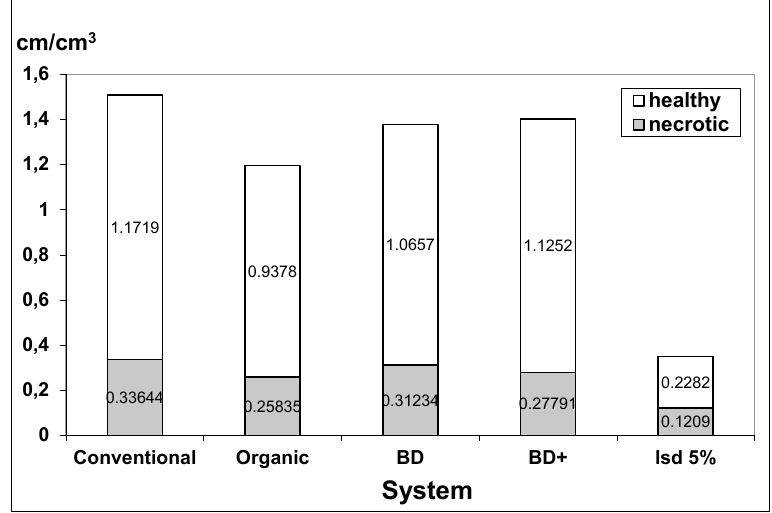
The root to stover + grain relationship was 16.5% for conventional, 10.4% for organic, 11.7% for biodynamic, and 12.6% for biodynamic + NCP.